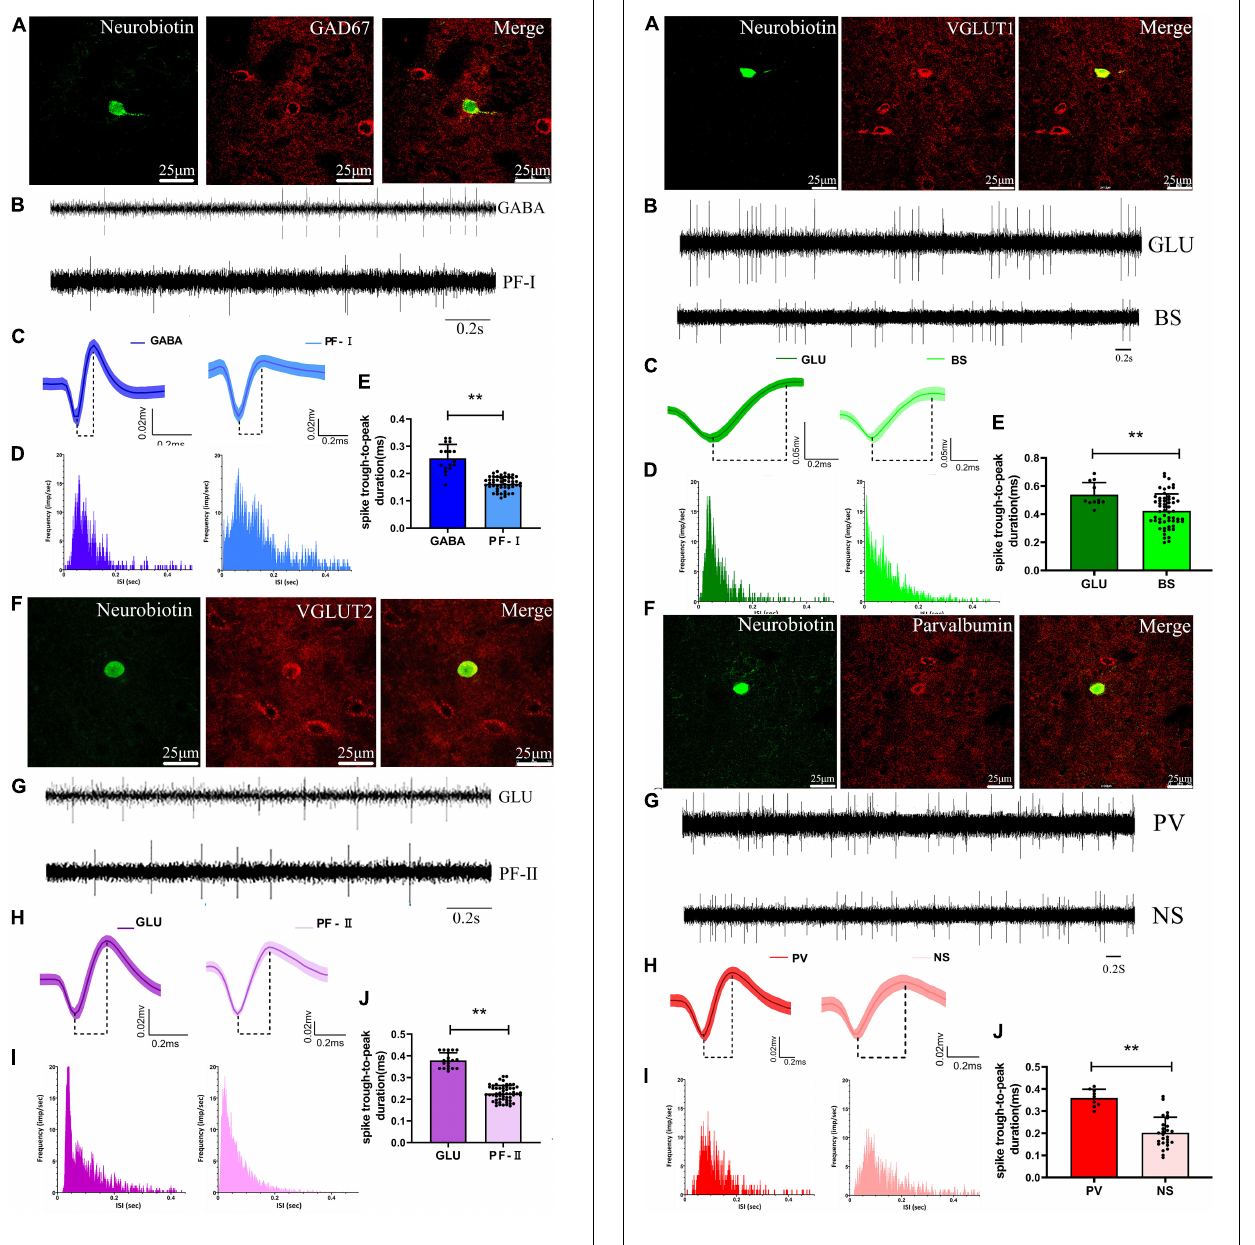
FIGURE 5 | Identified neurochemical and electrophysiological properties of PF neurons and comparison with microwire electrode characteristics. A representative fluorescent image of immuno-labeled GABA-positive neuron in the (A) PF, and of immuno-labeled GLU-positive neuron in the PF (F) . Compare examples of (B) baseline firing properties, (C) average extracellular waveform, and (D) interspike interval (ISI) distribution for the labeled γ -aminobutyric acid (GABA)ergic-positive neuron and microwire electrode recording PF-Ineurons, respectively. Comparison of examples of (G) baseline firing properties, (H) average extracellular waveform, and (I) ISI distribution for the labeled glutamatergic (GLU)-positive neuron and s electrode recording PF-II neurons, respectively. A significant difference in spike duration (trough-to-peak measure) both for the (E) GABA-positive neuron with PF-Iand the (J) GLU-positive neuron with PF-II neurons, respectively. ** p < 0.001.